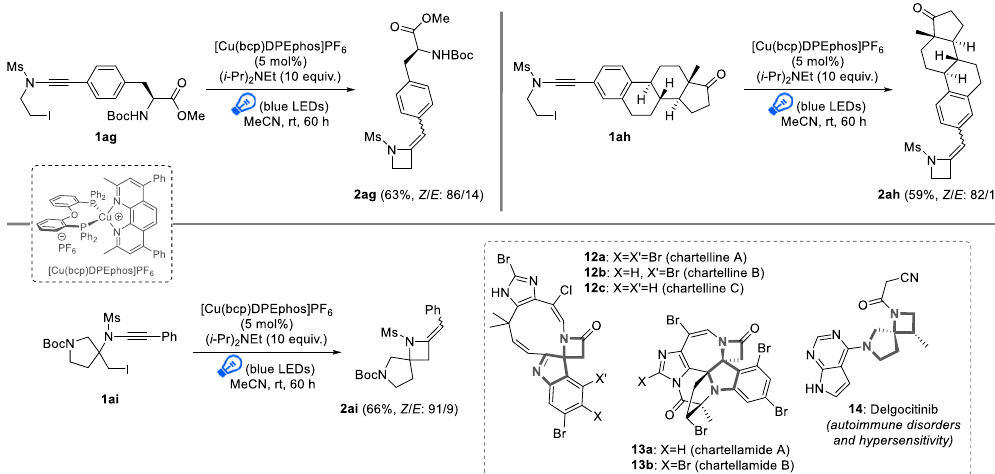
Fig. 4 Radical 4-exo-dig cyclization of ynamides to azetidines with complex substrates. Reaction conditions: ynamide 1 (0.2 mmol), [Cu(bcp)DPEphos] PF 6 (5 mol%), ( i -Pr) 2 NEt (2 mmol), MeCN (0.1 M), r.t., 60 h. Isolated yields are provided and Z / E ratios were determined by 1 H NMR analyses of the crude reaction mixtures.